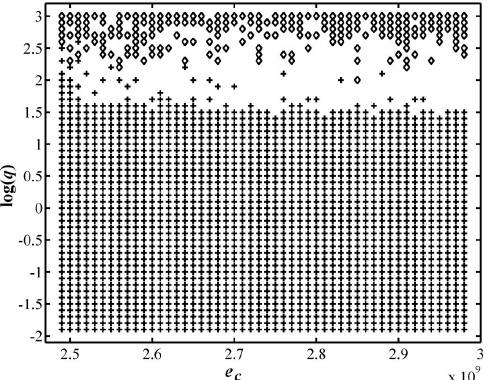
Fig. 9. Periodic-quasiperiodic-chaotic region diagram correspond- ing to varying parameters e c and log( q